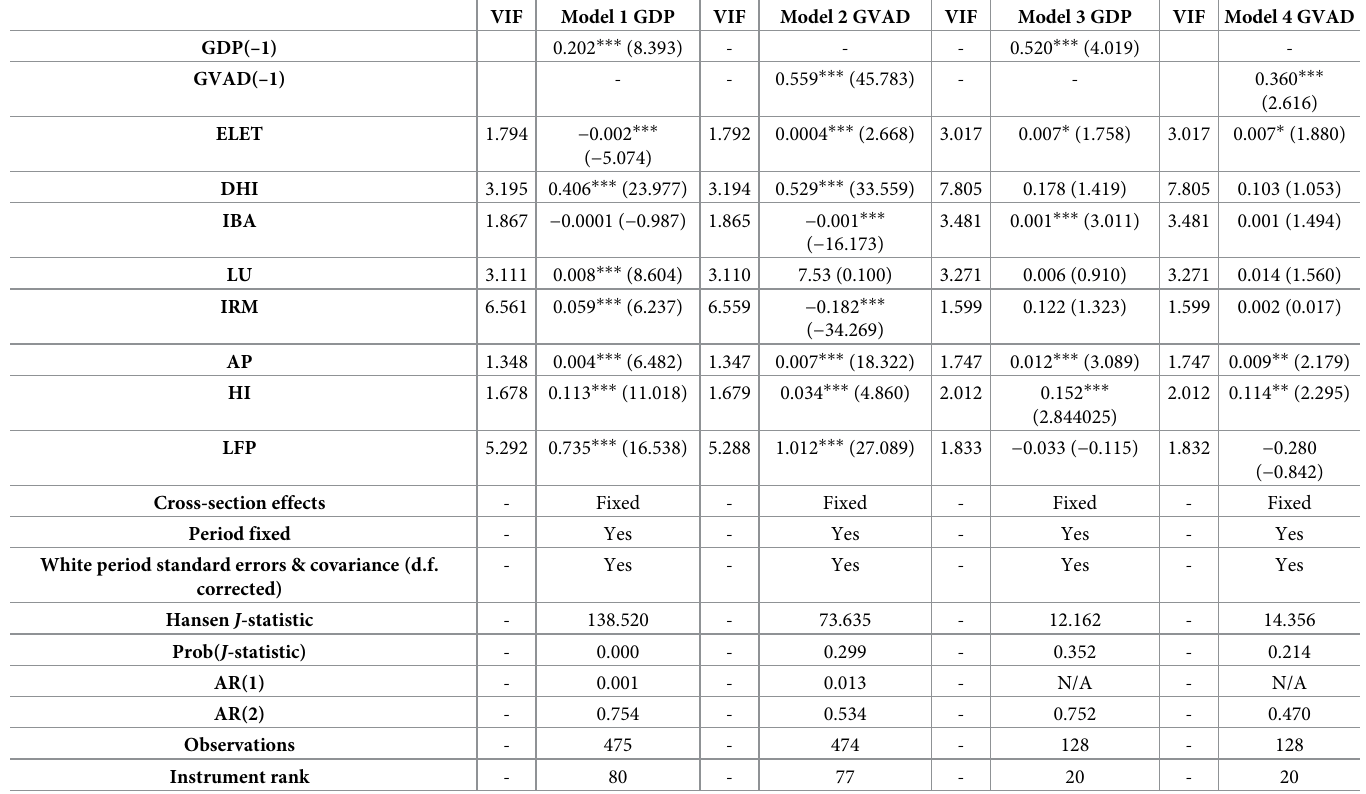
Table 7. Econometric models corresponding to the dependent variables GDP and